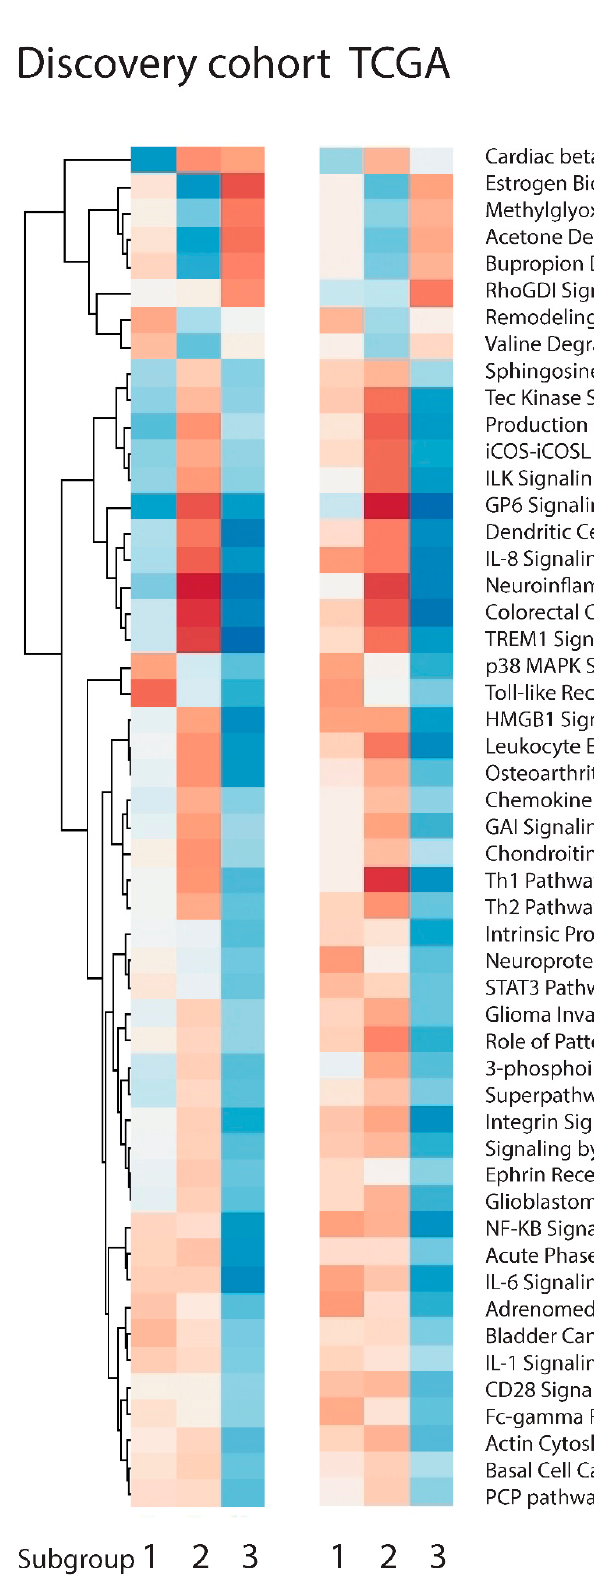
Figure 2. Heatmaps indicating IPA results for the AUMC ( left ) and TCGA ( right ) cohorts. In red, activated pathways, and in blue, de-activated pathways when comparing one subgroup to the other two subgroups.